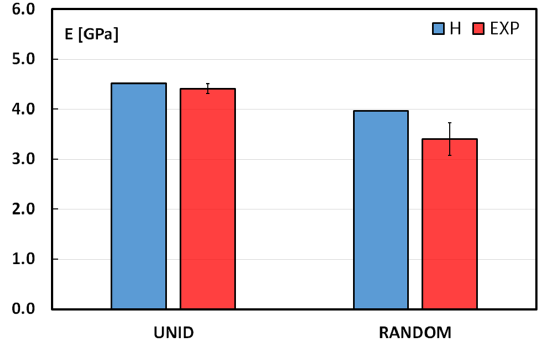
Figure 8. Comparison between Hill (H) and experimental data (EXP) for tensile moduli.